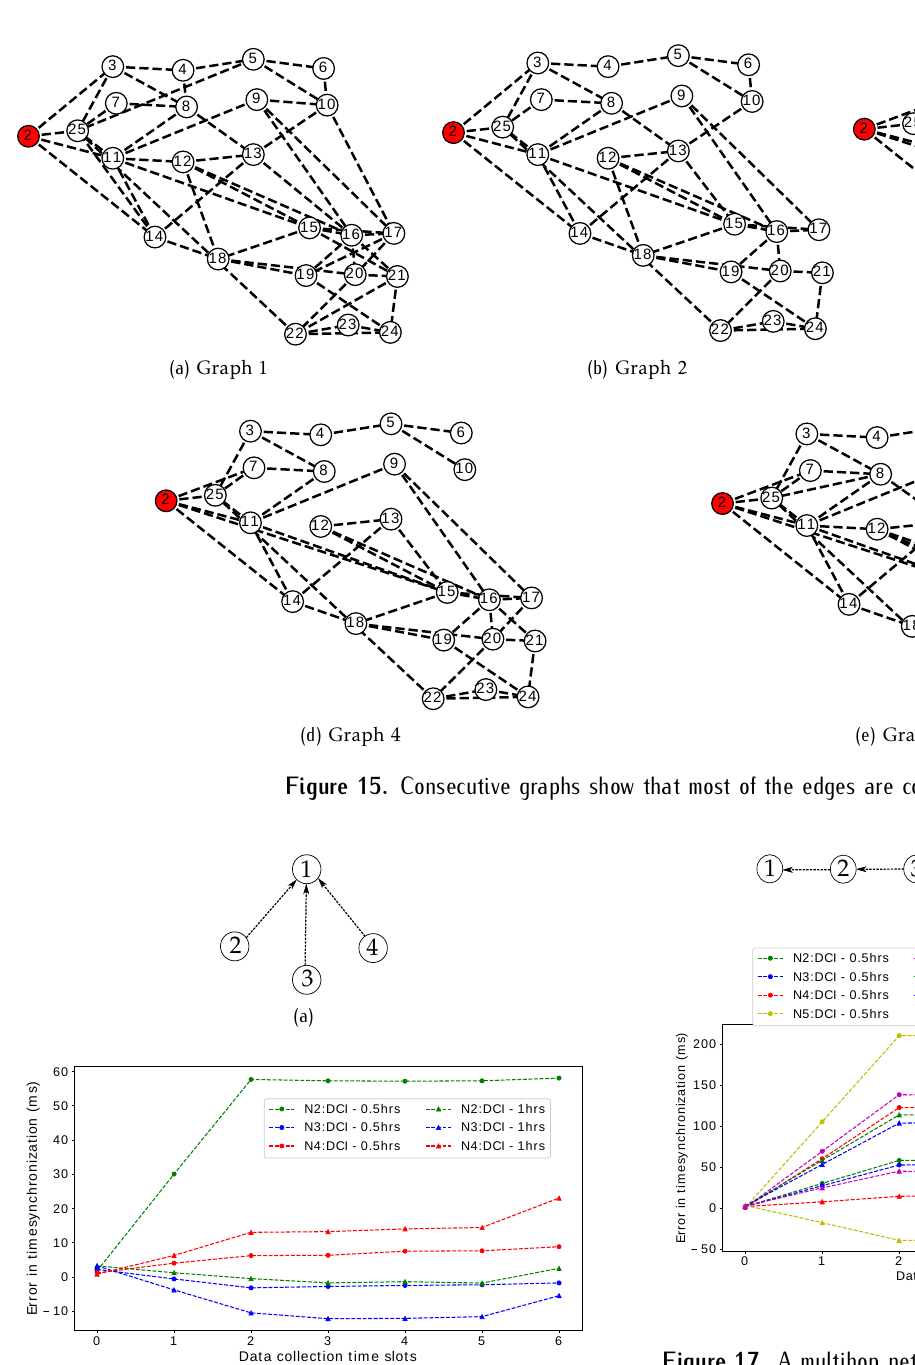
Figure 17. A multihop network and its synchronization errors in the form of a sleep message as detailed in Section 4.6. Each node could find its skew within the initial two or three time slots after which the error remains almost constant in the upcoming time slots. These errors are in the range of milliseconds and for our monitoring application, we believe that we can tolerate these error levels instead of employing a complicated time synchronization